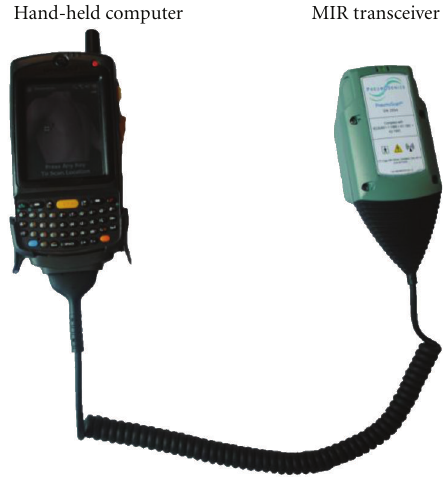
Figure 1: PneumoScan device.